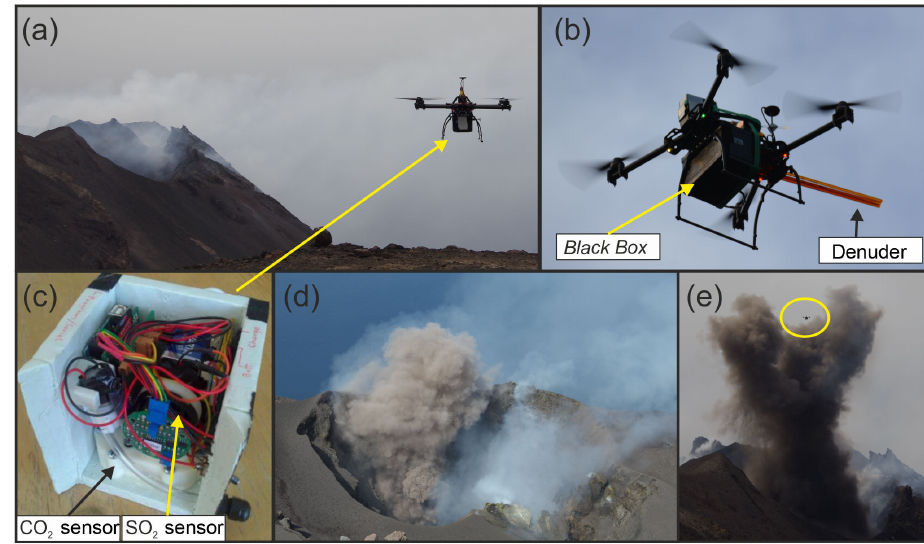
Figure 3. (a) Sampling site at Stromboli volcano with the northeastern crater in the background and the RAVEN UAV carrying the Sunkist gas monitor, (b) RAVEN UAV with the black box sampling unit and three gas diffusion denuders, (c) interior view of the Sunkist gas monitor, showing the CO 2 and SO 2 sensors, (d) passive degassing (white plume) and eruptive ash explosion (brown ash cloud) at the northeastern crater at Stromboli volcano, (e) ash eruption at the northeastern crater producing an ascending ash plume with the RAVEN UAV in direct proximity (yellow circle), returning from sampling